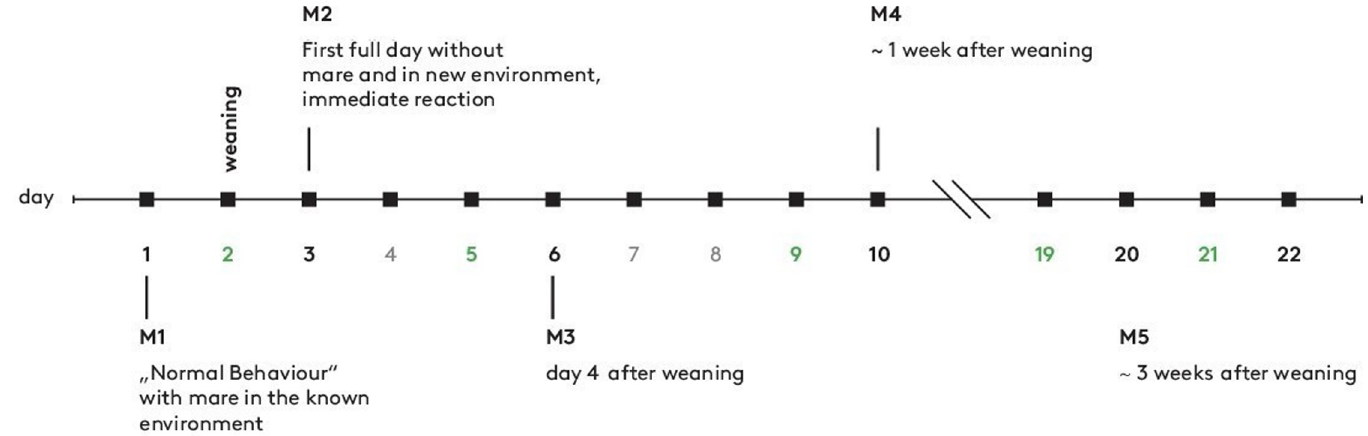
Fig 1. Timeline of the observation period. The black numbers represent the days of behavioral observation and feces collection; M1–M5 = measurement 1–5; the green numbers represent the day to which the 11,17 Dioxoandrostane results are related due to the 24-hour delay in the detectability of cortisol metabolites in feces.